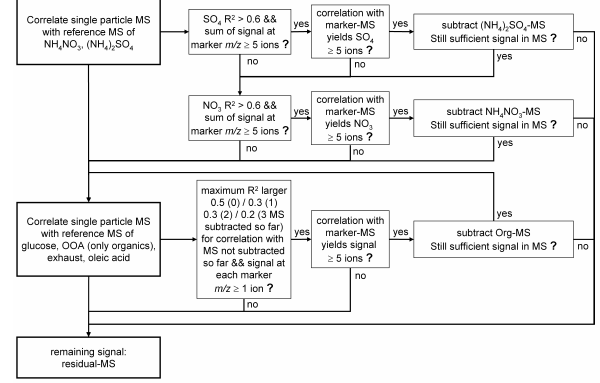
Fig. 2. Schematics of the developed classification algorithm. SO 4 : sulphate; NO 3 : nitrate; Org: organics; MS: mass spectrum; &&: logical AND. For further information on the different steps, refer to Sect.